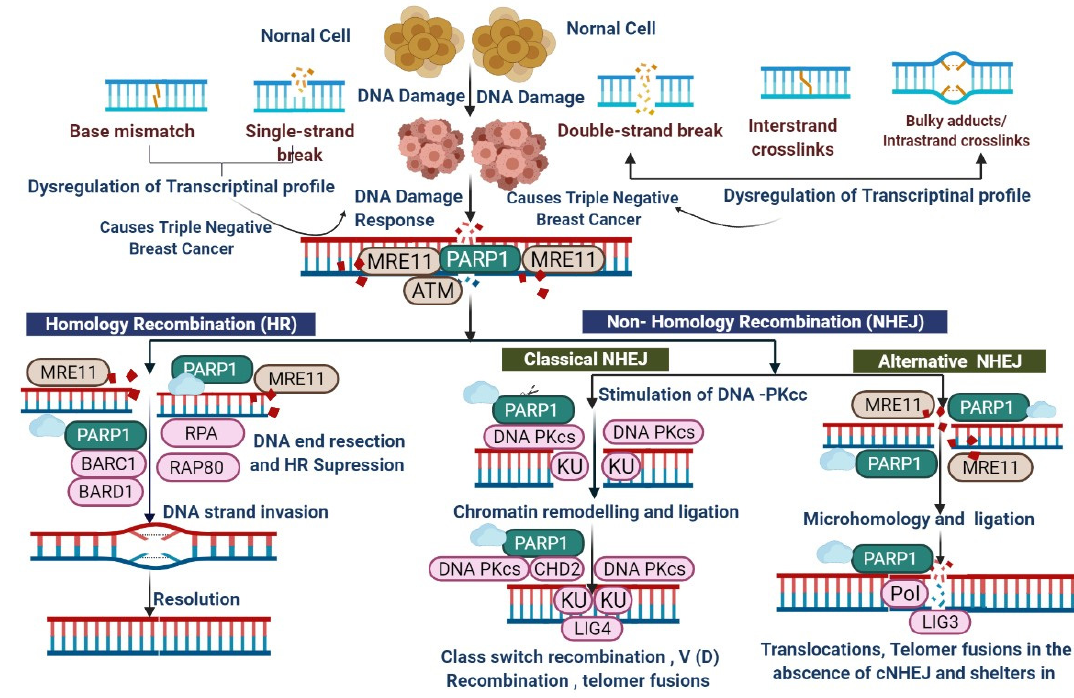
Figure 3. PARP1 is required for the robust detection of DNA double-strand breaks (DSBs) and for the initial DNA damage response through its interaction with MRE11 (meiotic recombination 11) and the apical checkpoint kinase ATM (ataxia telangiectasia mutated). PARP1 has a role in DNA end resection during the HR process through the recruitment of MRE11 to DSBs, which is followed by binding of the single strand by replication protein A (RPA); the reaction is carried out with BRCA1 -associated BARD1 (RING domain protein 1). PARP1 also actively participates in DSB repair by activating NHEJ. When DSBs are directed for repair by cNHEJ, they are mediated by KU70KU80 dimers, which trigger DNA-PKcs (DNA-dependent protein kinase catalytic subunits). PARP1 interacts with DNA-PKcs and activates them without the requirement of KU proteins. PARP1 also plays an important role in chromatin remodeling during cNHEJ by facilitating the recruitment of CHD2 (chromodomain helicase DNA-binding protein 2), which then activates XRCC4 (X-ray repair cross-complementing protein 4) and LIG4 (DNA ligase 4) for DNA ligation. PARP1 has a role in alternative NHEJ (aNHEJ), which is active in the absence of cNHEJ. aNHEJ requires the processing of DNA ends by MRE11 , which is recruited by PARP1. The resected ends are then joined through sequence microhomology, and the gap is filled by Pol theta (DNA polymerase θ ) and ligated by